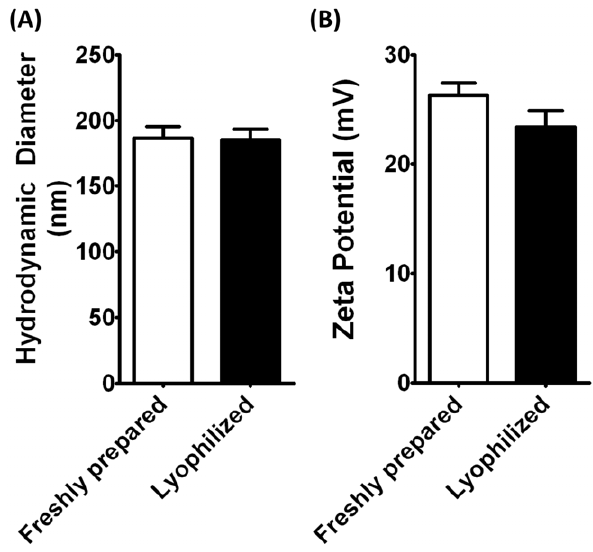
Figure 9. Biophysical characterization of nanoparticles before and after lyophilization. (A) Hydrodynamic diameter of freshly prepared DNA/B5-S5-E7 particles versus lyophilized particles (n=3; bars are standard error). (B) Zeta potential of freshly prepared DNA/B5-S5-E7 particles versus lyophilized particles (n=3; bars are standard error). Differences in particle size (p=1) and zeta potential (p=0.05) are not significant.